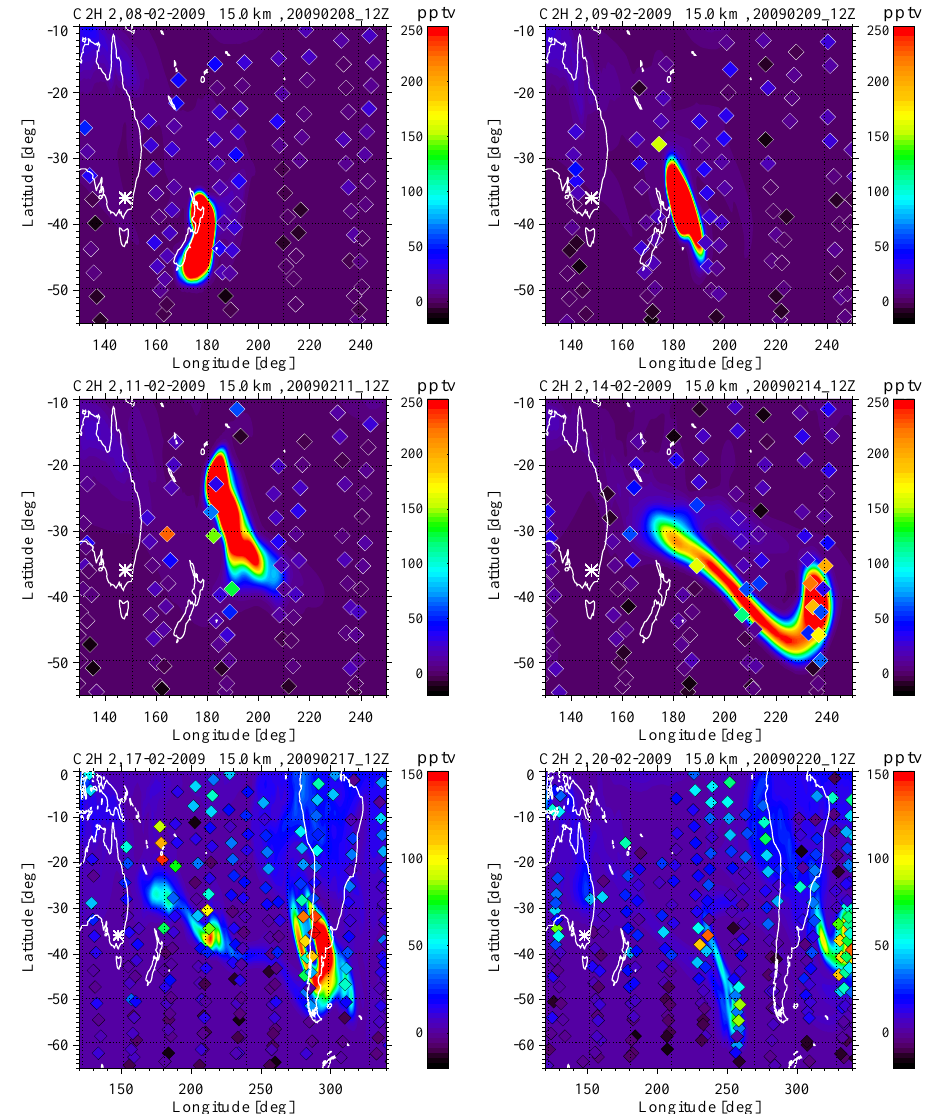
Fig. 3. MIPAS C 2 H 2 data at 15km altitude (diamonds), measured on 8, 9, 11, 14, 17 and 20 February 2009 (top left to bottom right). Background areas are GEM-AQ C 2 H 2 model distributions for 12UT of the respective days. Model distributions are smoothed vertically and along-track to MIPAS resolution. Note the different map section and colour scale for the bottom panel. Red diamonds with black pluses inside indicate MIPAS VMRs higher than 250 (150)pptv, and red areas are GEM-AQ data equal to or higher than 250 (150)pptv. The white star indicates the location of the Kilmore East